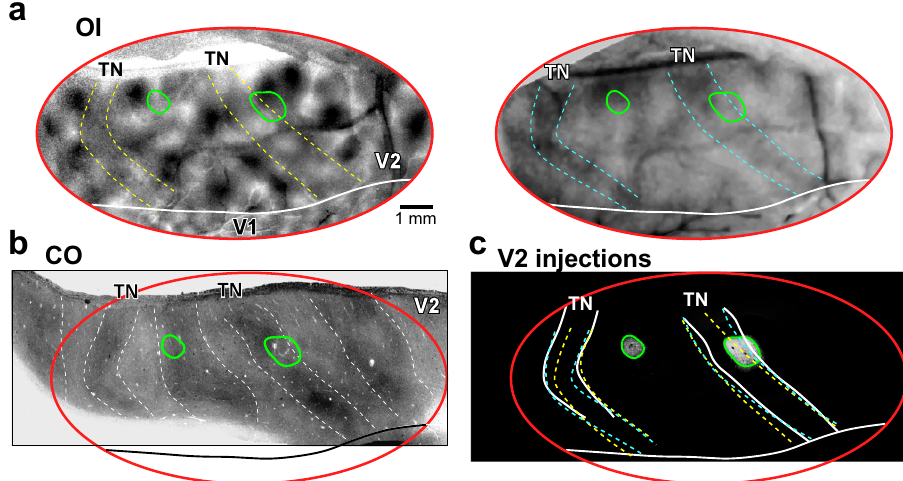
Fig. 3 Injection sites in V2 thick and thin stripes. Case MK356RH. Two AAV9-GFP injection sites, one con fi ned to a V2 thick stripe, the other to a thin stripe. a Orientation (45 – 135°; left) and SF (low-high; right) difference maps in V2. Dashed contours delineate regions having weak orientation responses (yellow), and preferring low SFs (cyan), corresponding to thin stripes; solid white contour: V1/V2 border based on the orientation map. b Stack of aligned and merged tangential V2 tissue sections stained for CO, revealing the stripe pattern. Red oval: imaged region from ( a ), determined based on the same alignment procedure described for a different case in Supplementary Fig. 1. Dashed white contours outline the TN and thick stripes; solid black contour: V1/ V2 border based on the orientation map. c Micrographs of the two AAV9-GFP injection sites taken under fl uorescent illumination and outlined, with superimposed outlines of TN stripes based on CO (white) and OI maps (yellow, orientation, cyan, SF). Note the good correspondence between functionally-de fi ned and CO-de fi ned stripes. The outlines of the injection sites (green ovals) indicate the location of the injection sites on CO sections ( b ) and OI ( a ) maps. These injection sites in ( a – c ) are representative of six independent injections centered in thin ( n = 3) or thick ( n = 3) V2